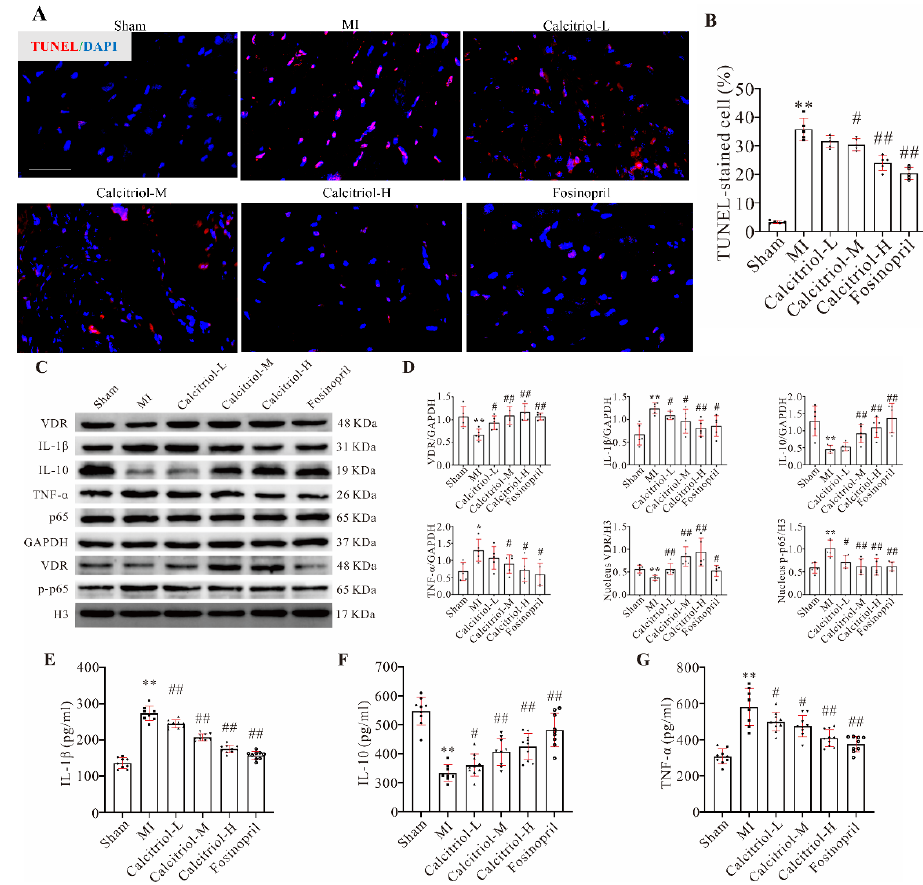
Figure 4. Calcitriol inhibited MI-induced cardiac myocyte apoptosis and death, as well as inflam- mation by modulating VDR signaling . ( A , B ) Calcitriol decreased myocyte apoptosis and death. Representative photographs ( A ) and quantitative analysis of TUNEL staining of the cardiomyocytes in mice with the indicated treatments ( n = 5). Scale bar represents 50 µ m. ( C , D ) Western blot analysis of protein expressions in the whole-cell lysates (VDR, IL-1 β , IL-10, TNF- α , and NF- κ B p65) or nuclear lysate (VDR and p-NF- κB p65) in mice with various treatments ( n = 5). ( E – G ) Serum IL- 1β, TNF- α, and IL -10 levels in mice with the indicated treatments ( n ≥ 8). Data presented here are rep- resentative images ( A , C ) or quantitative analysis ( B , D – G ), respectively. (Scale bar represents 50 μm. Data represent means ± S.D. * p < 0.05, ** p < 0.01 versus sham group, # p < 0.05, ## p < 0.01 versus MI group; one-way ANOVA with a post hoc test of Tukey’s analysis).